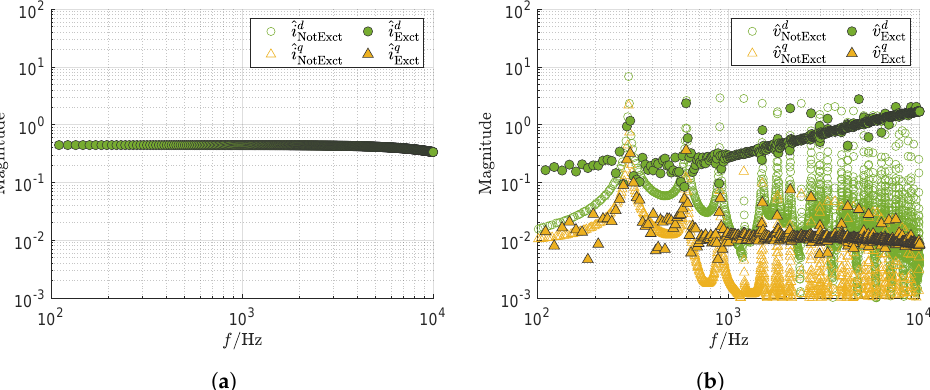
Figure 15. Measurement of the realistic impedance scenario during excitation of the d -axis. ( a ) Spec- trum of the current i meas in the dq domain. ( b ) Spectrum of the voltage v meas in the dq domain. A similar condition can be observed in the second measurement M2 when the q -axis is excited as shown in Figure 16a. Since the power spectrum is the same as in Figure 12a, the same observations apply. The spectrum of the voltage response in Figure 16b is the superposition of the harmonics, distorted by the leakage effect, in Figure 10b and the voltage response from the ideal scenario in Figure 13b. The harmonics do not distort the measurement M2 as much as the measurement M1, because the q component of the harmonic current ˆ i harm is smaller than the d component. This results in a clearer voltage response of the system, which is represented by the strong deviation of the excited frequency bins ˆ v q compared to the nonexcited frequencies ˆ v q . The obvious M2,Exct M2,NotExct cross coupling in Figure 13b between the excitation current in the q -axis and the voltage response in the d -axis is difficult to identify. It is overlaid by the harmonics, which can be seen by the fact that the excited frequencies ˆ v d do not lift off from the neighboring M2,Exct nonexcited frequencies ˆ v d M2,NotExct